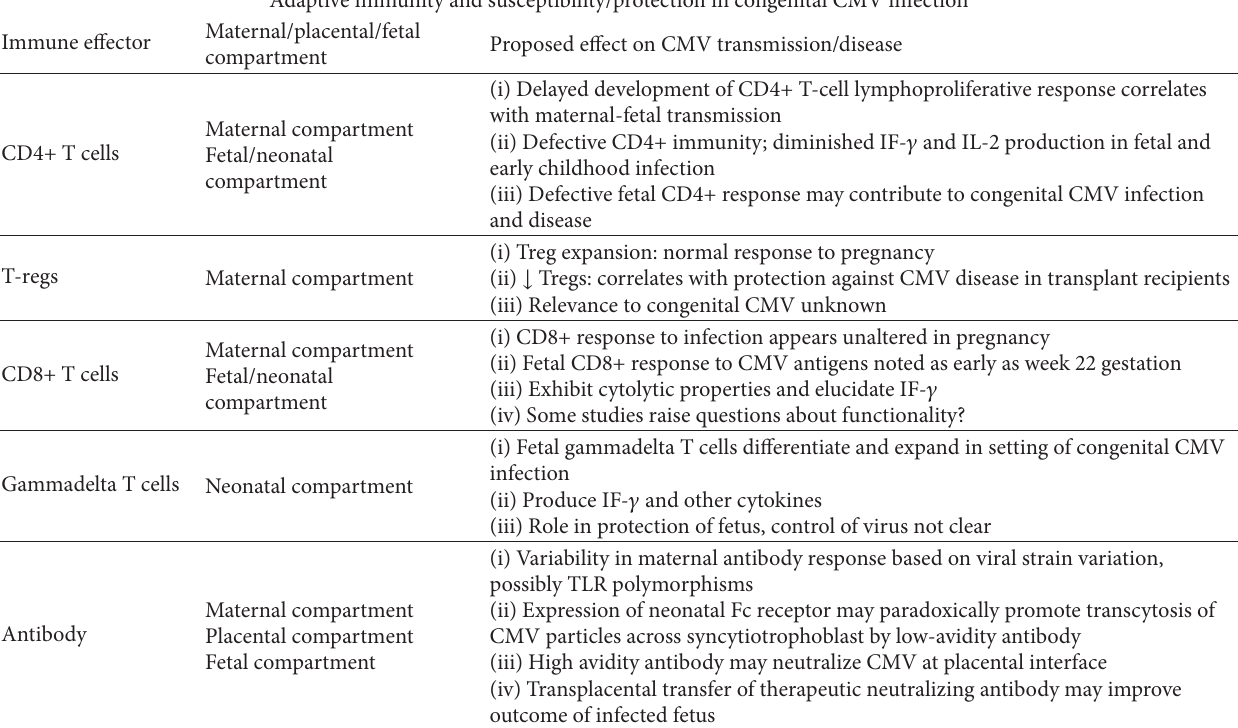
Table 2: Summary of adaptive immune responses and their proposed role in control of or susceptibility to congenital CMV infection. Adaptive immunity and susceptibility/protection in congenital CMV